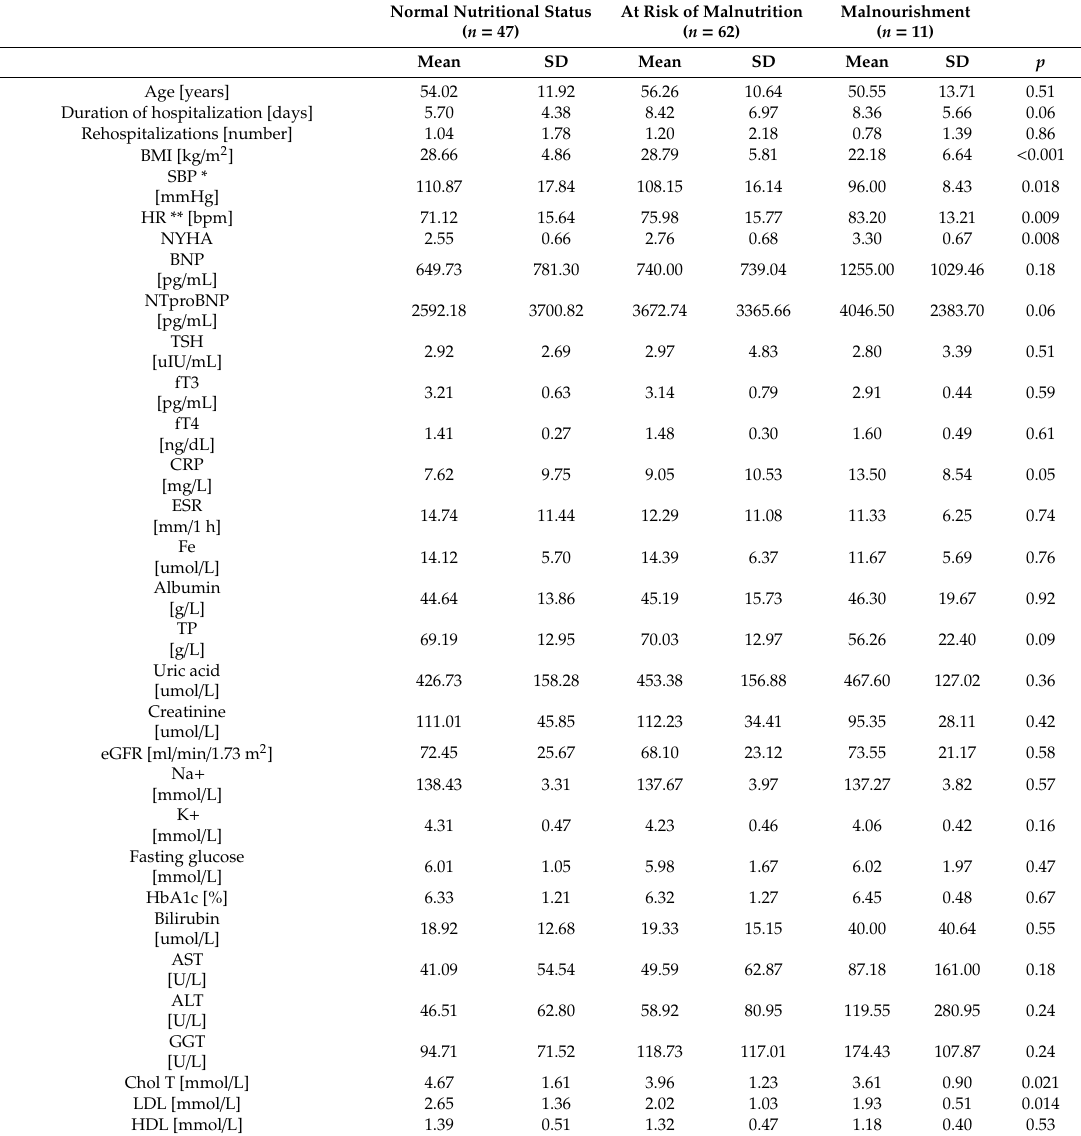
Table 1. Clinical and laboratory characteristics of ‘normal nutritional status’, ‘at risk of malnutrition’, and ‘malnourishment’